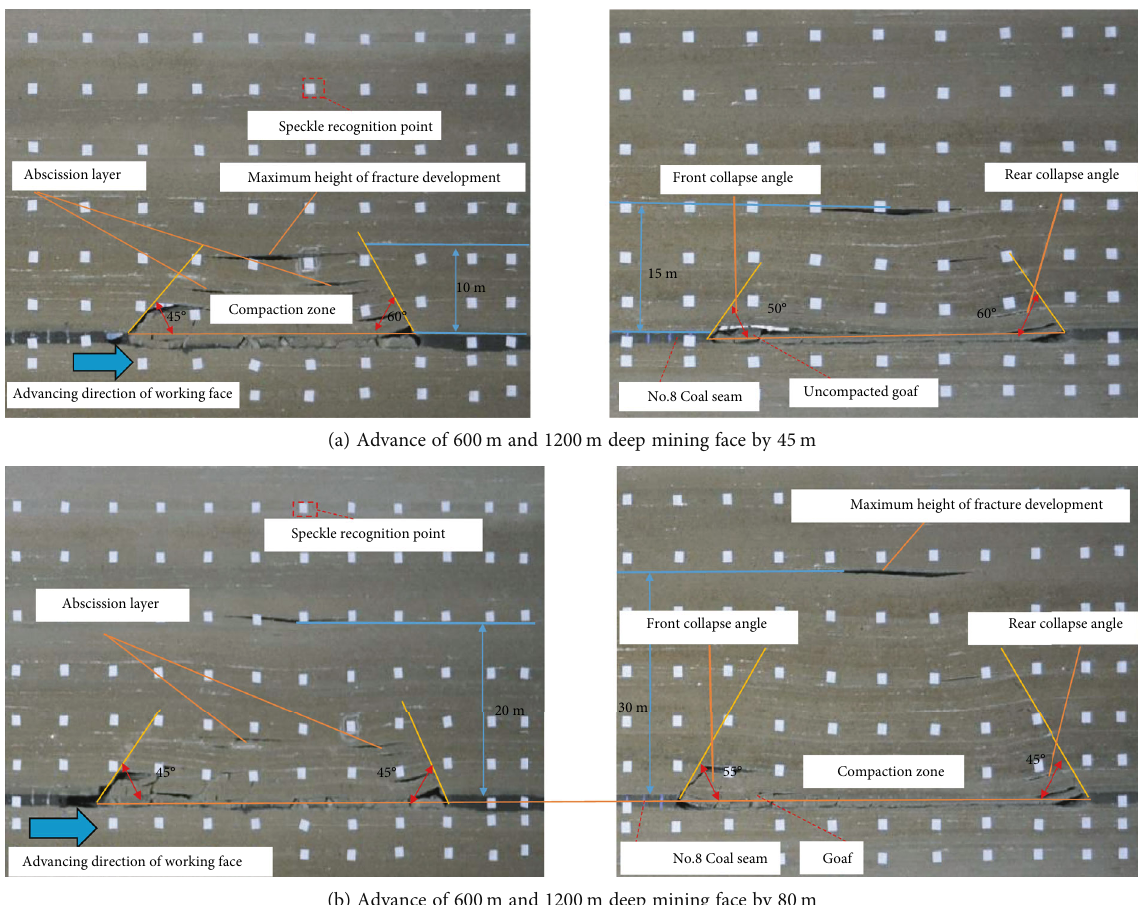
Figure 14: The deformation law of overlying strata under 600 m and 1200m mining depth when advancing the same